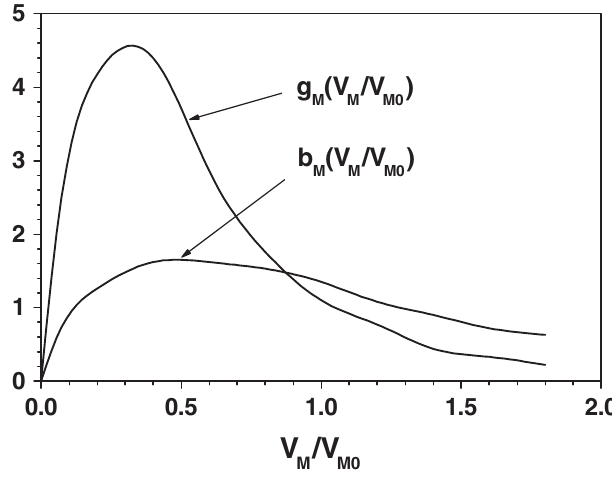
FIG. 6. Conductance, g tron vs relative magnetron cavity voltage, V